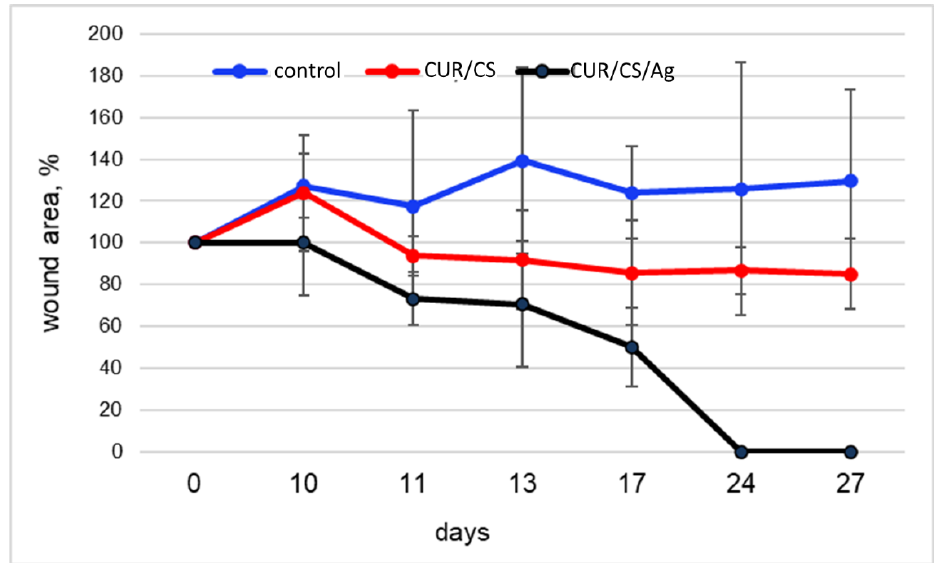
Figure 10. The influence of membranes (red—CUR/CS; black—CUR/CS/Ag; blue—untreated control) on the dynamics of the wound defect closure. The graph shows the dynamics of the closure of a full-thickness skin defect in mice with genetically determined type 2 diabetes mellitus. Each animal (n = 3 in each group in total) received a control wound (without therapy) and an experimental wound (treatment with test materials). The percentage of closure was calculated based on the initial size of the wounds in order to assess the actual dynamics of healing. The graph shows the increase in the sparing of the control wounds for all observation times, as well as wounds with CUR/CS therapy on day 10 (removal of the dressing).